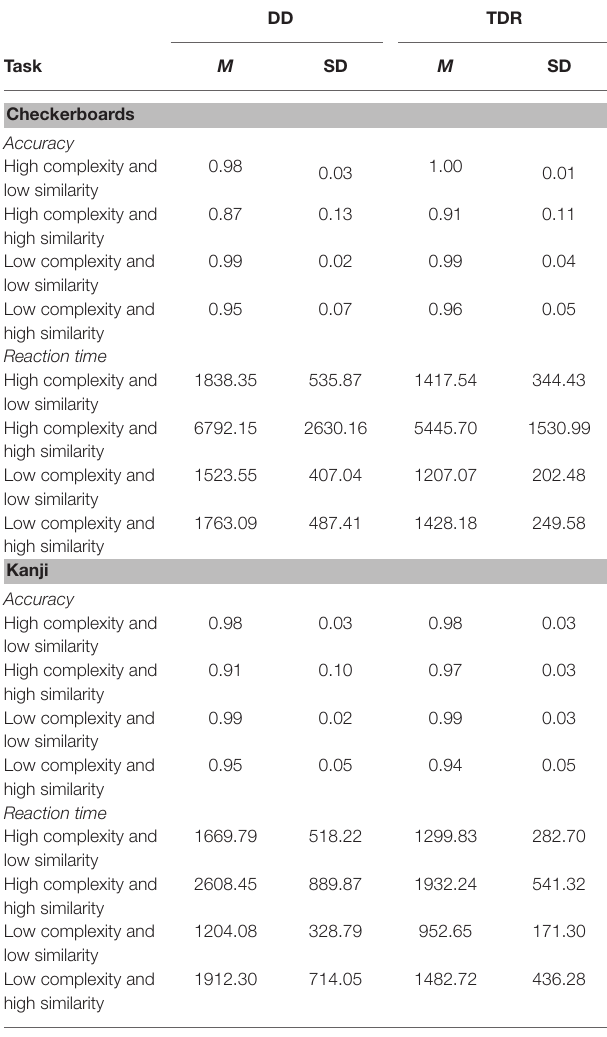
TABLE 2 | Mean ( M ) and standard deviations in four conditions of the checkerboards and Kanji tasks.